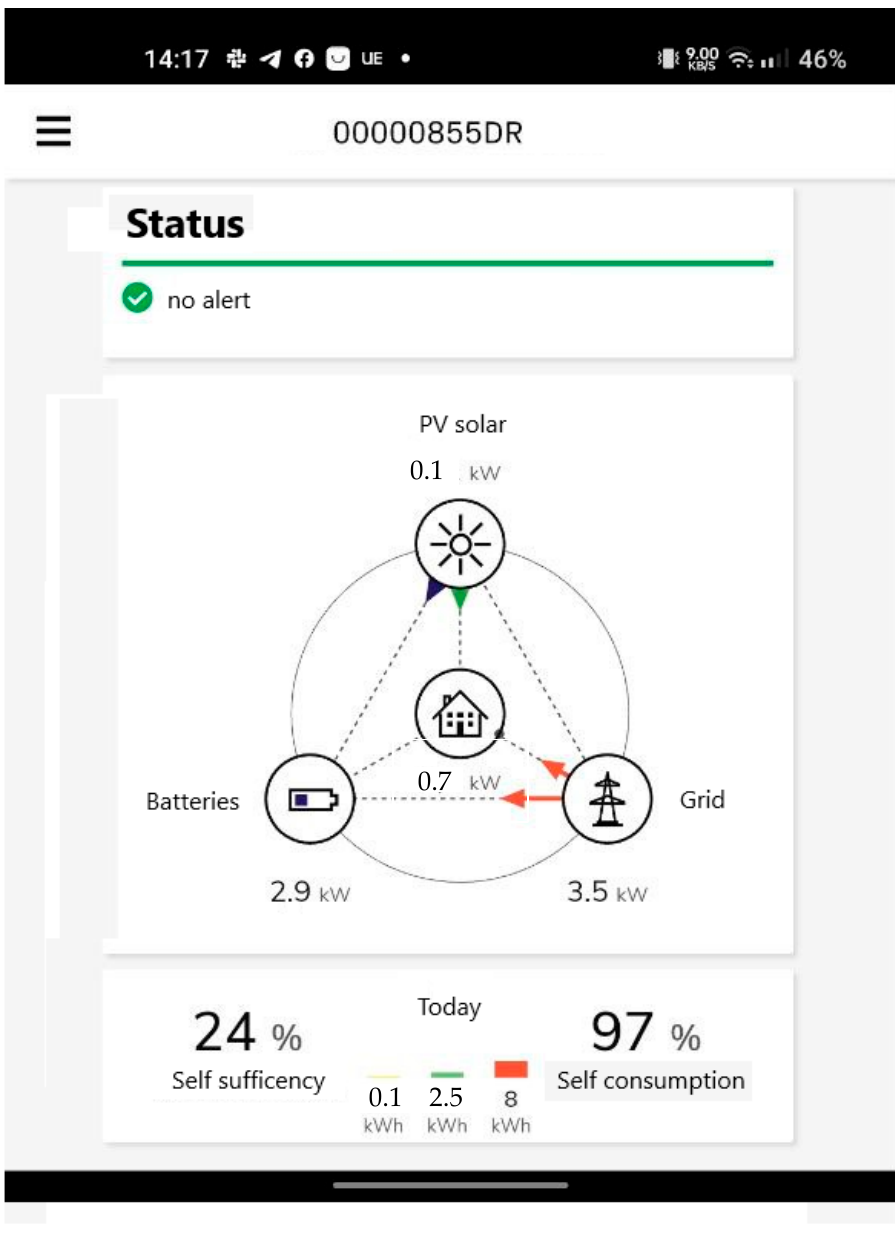
Figure 12. ABB dashboard and the batteries charge at 2.9 kW power. 3.2. Test 2: Home Gateway, SunSpec Adapter and 4 kW-4 kWh SolarEdge Battery Storage The 4 kW-4 kWh SolarEdge battery storage under study is shown in Figure